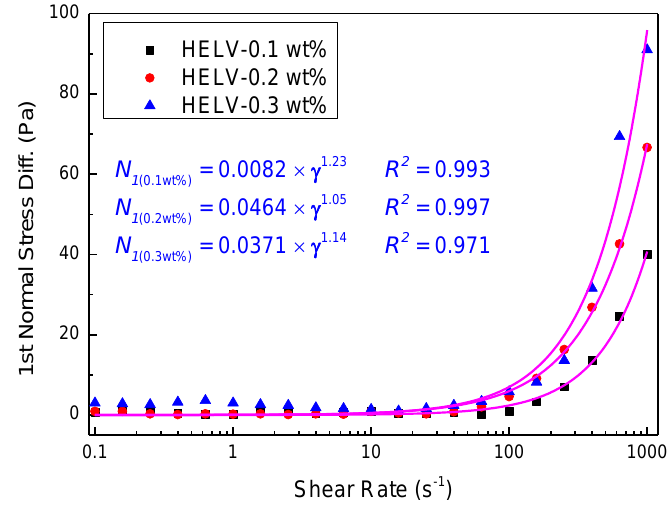
Figure 7. First normal stress difference N 1 versus the shear rate profiles for the study ′ s tested fluids.